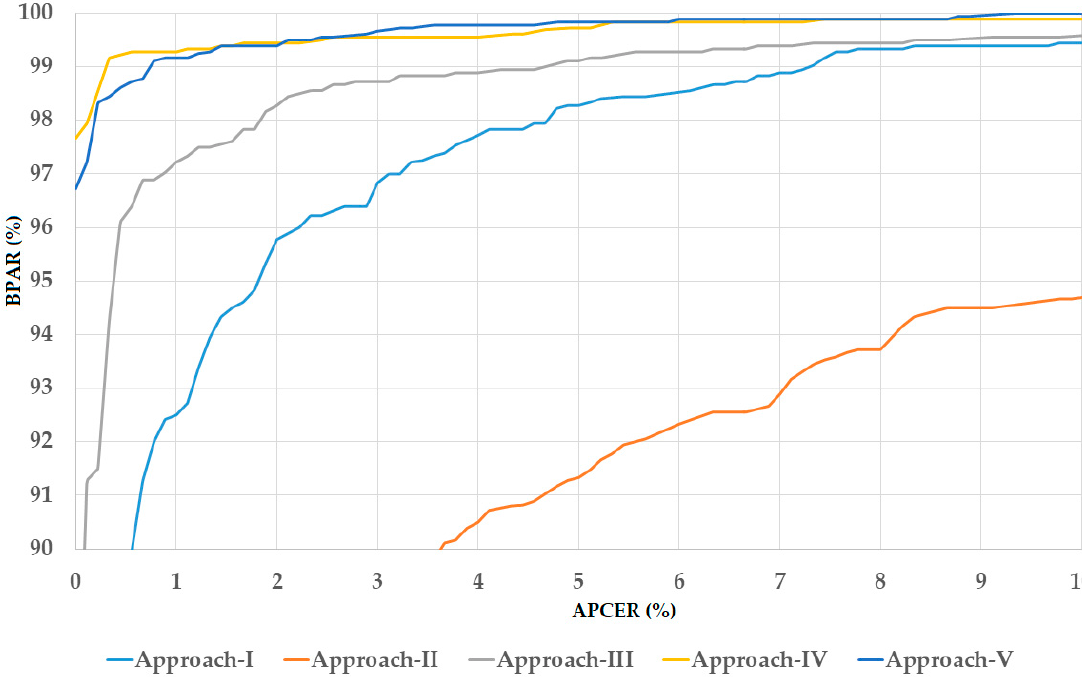
Figure 8. DET curves of iPAD systems according to best detection accuracy in Table 7b using the three ‐ channel images of fusion of gray and Retinex images for iPAD.